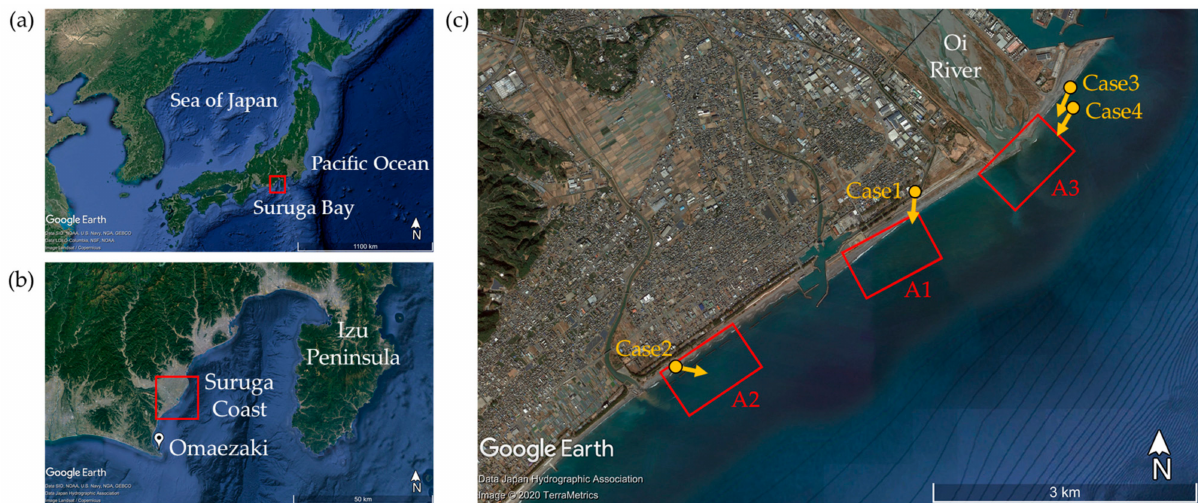
Figure 1. Study area: ( a ) location of the Suruga Bay, ( b ) location of the Suruga Coast and ( c ) Oi River, and three test areas, A1, A2, and A3 on the Suruga